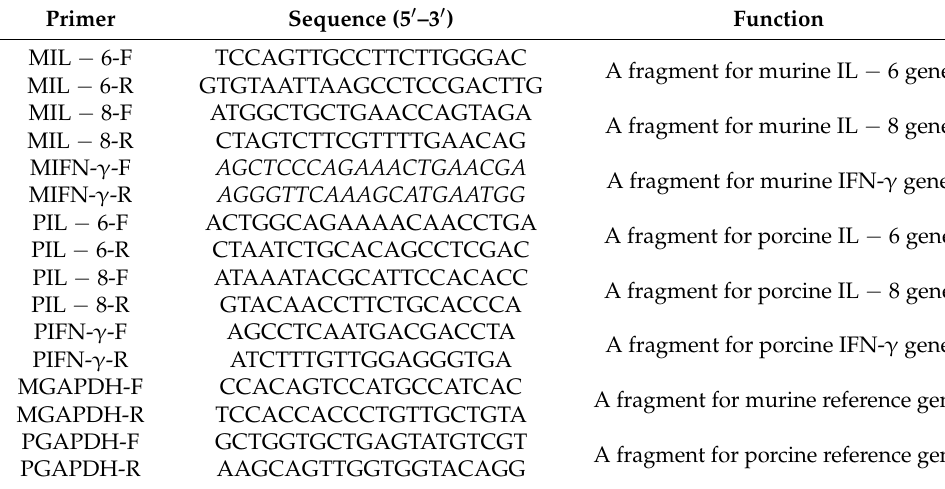
Table 5. Primers used for